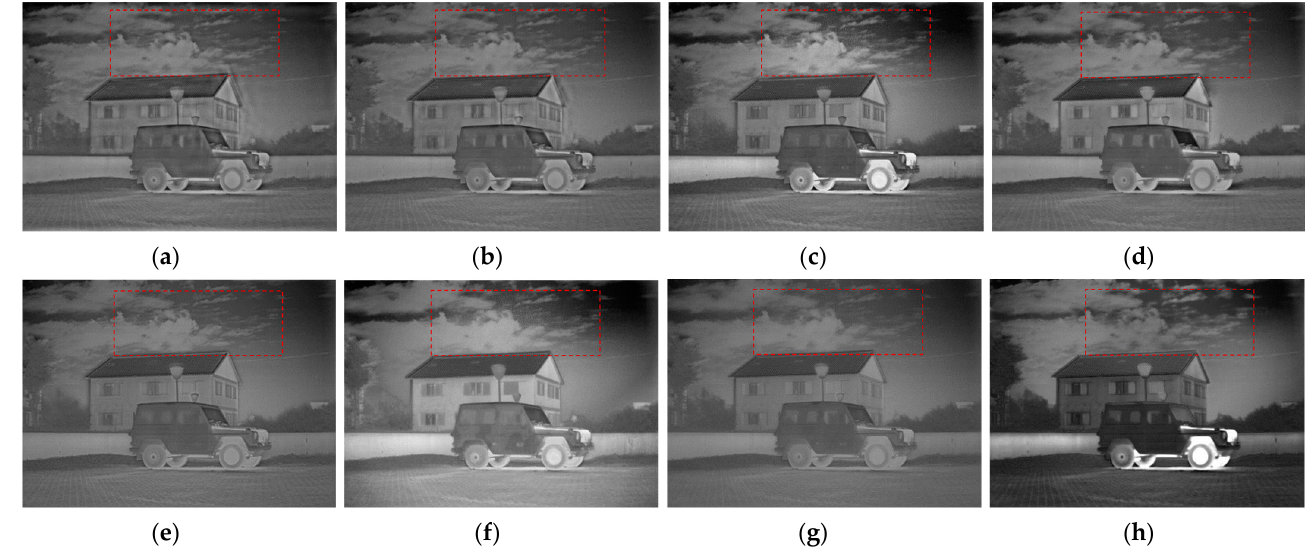
Figure 7. Performance comparison of different fusion methods on the image pair “Marne”. ( a – h ) are the results of CVT, CWT, WLS, LP, ADF, GTF, MSVD and our algorithm, respectively.